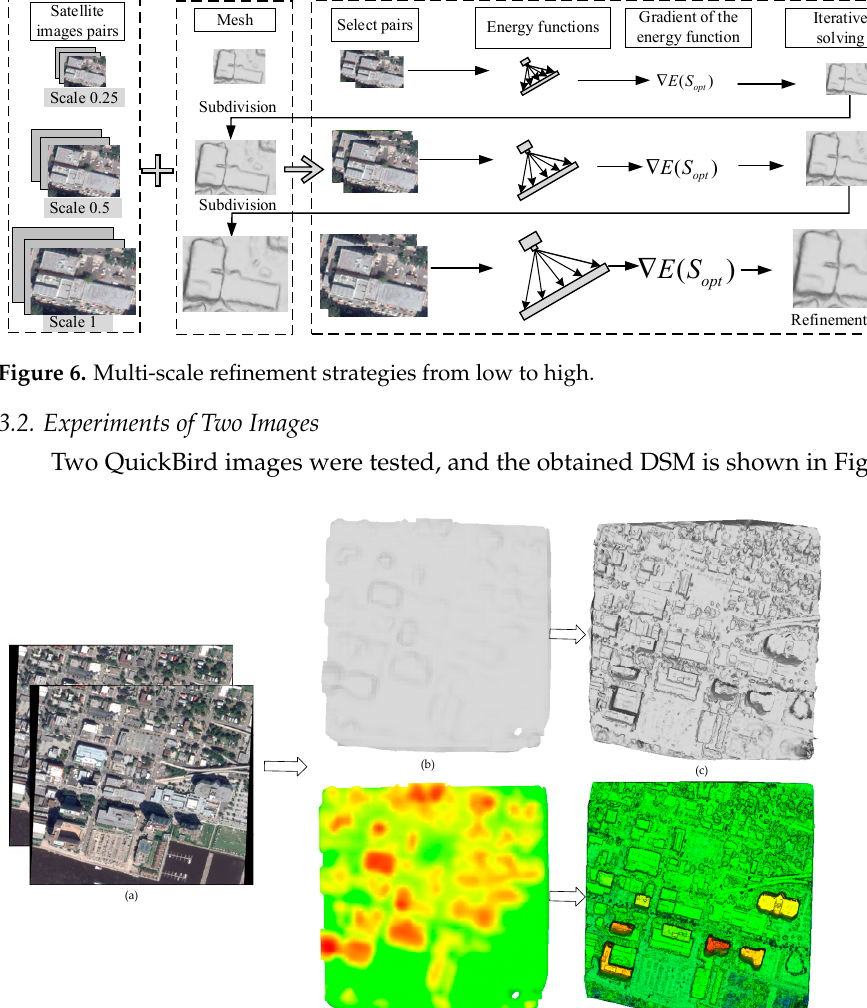
Figure 6. Multi-scale refinement strategies from low to high.